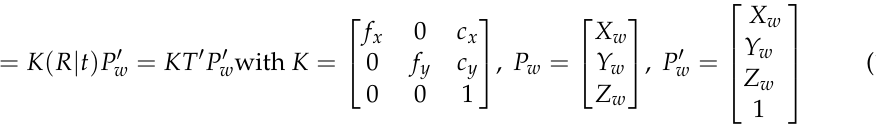
Figure 5. Camera and IMU timestamp association.